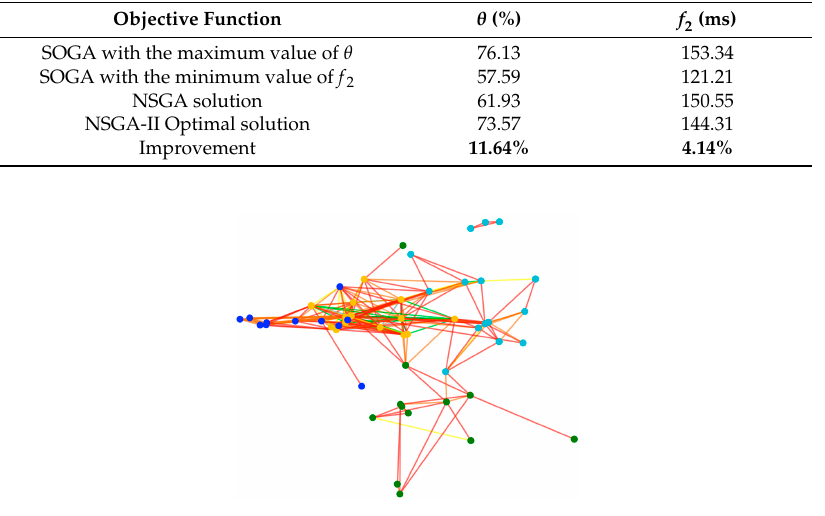
Table 5. Comparison of NSGA-II with other genetic algorithm in AB-Graph partition problem.